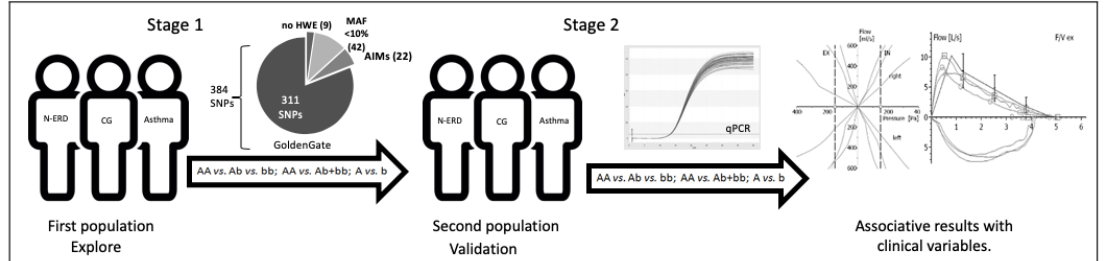
Figure 1. N-ERD non-steroidal anti-inflammatory drugs exacerbated respiratory disease. CG: control group. No-HWE: no Hardy–Weinberg equilibrium. MAF: minor allele frequency. AIMs: ancestry informative markers, qPCR: quantitative polymerase chain reaction.